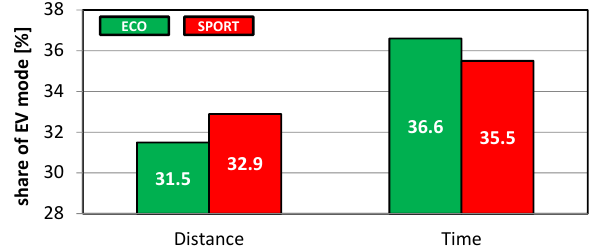
Fig. 18. Vehicle's operating time share in electric mode relative to the time and distance traveled Analysis of the EV mode operating intervals depending on the driving conditions (urban, rural, highway) indicates